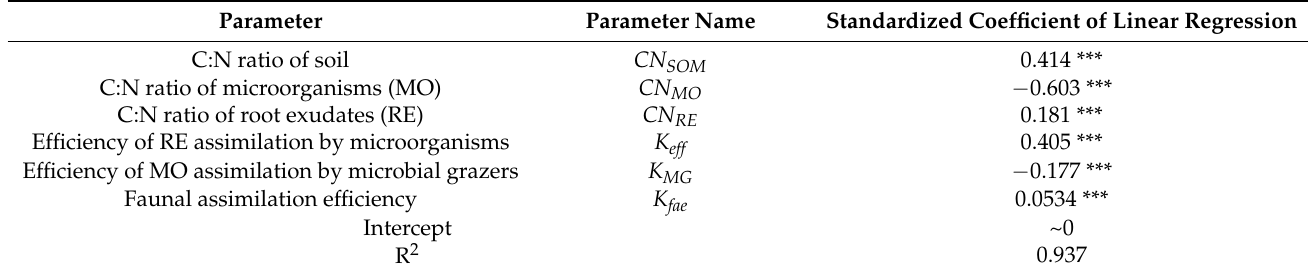
Table 3. Analysis of the model sensitivity to parameter variations.